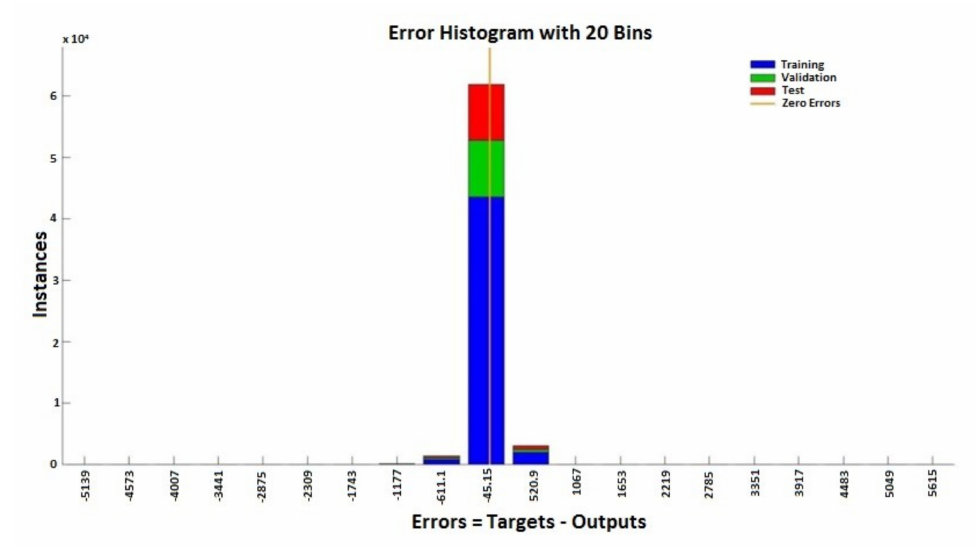
Figure 14. Error histogram—ANN with 150